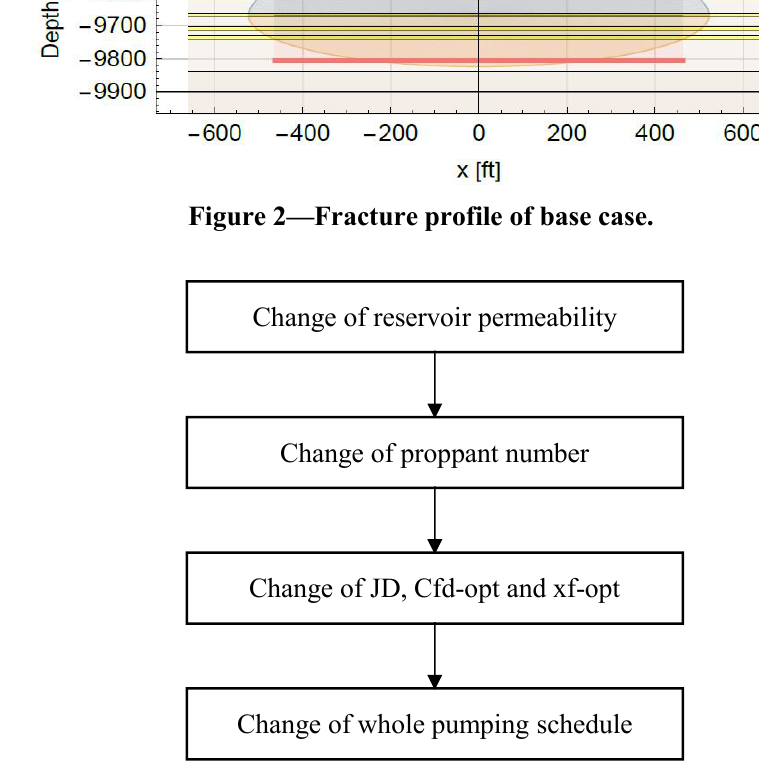
Figure 3—Effect of reservoir